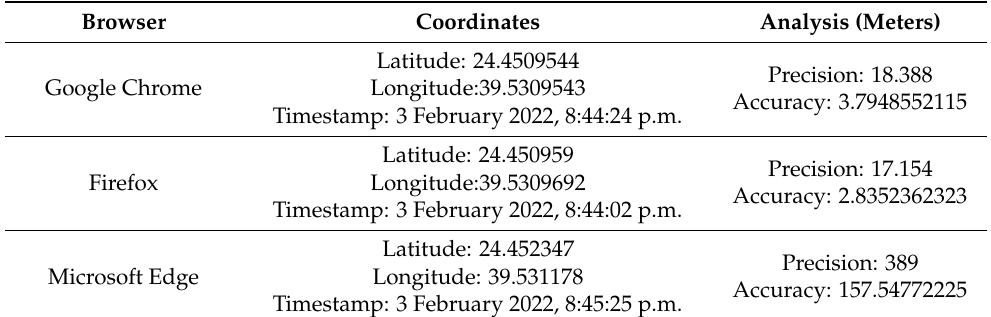
Table 4. Result and Comparison of W3C Geolocation API in Windows by a wireless network (DSL).